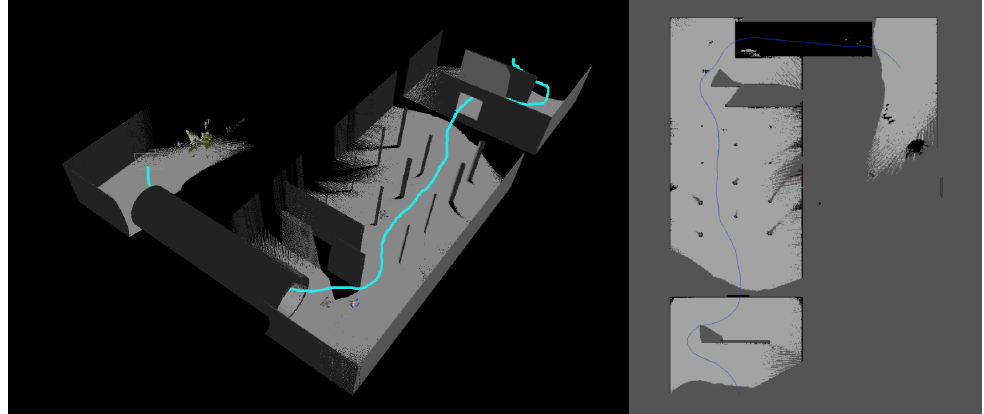
Figure 21. Visualization of the trajectory of UAV controlled by the SCAN algorithm (Area 1 and Area 3).